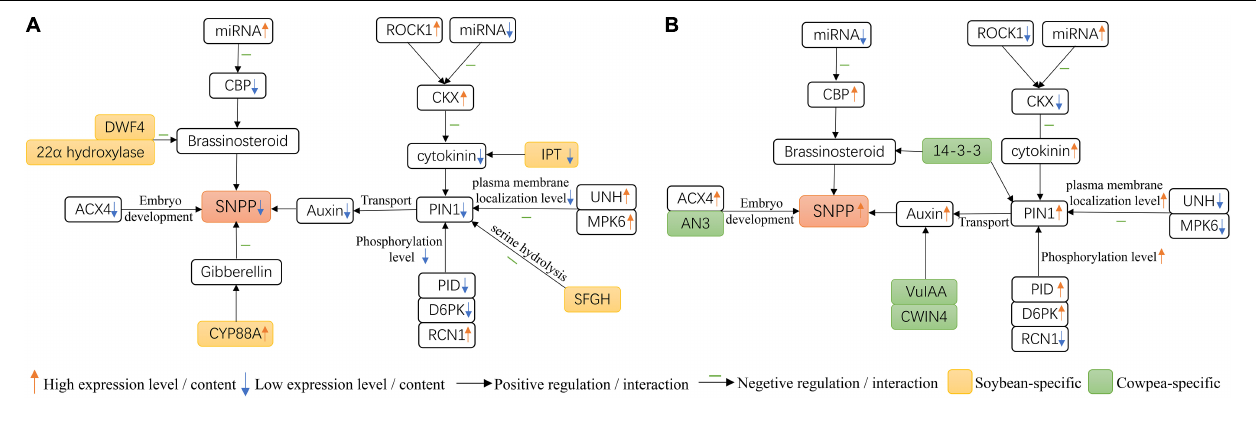
FIGURE 7 | Molecular mechanisms for the difference of seed number per pod (SNPP) in (A) soybean and (B)